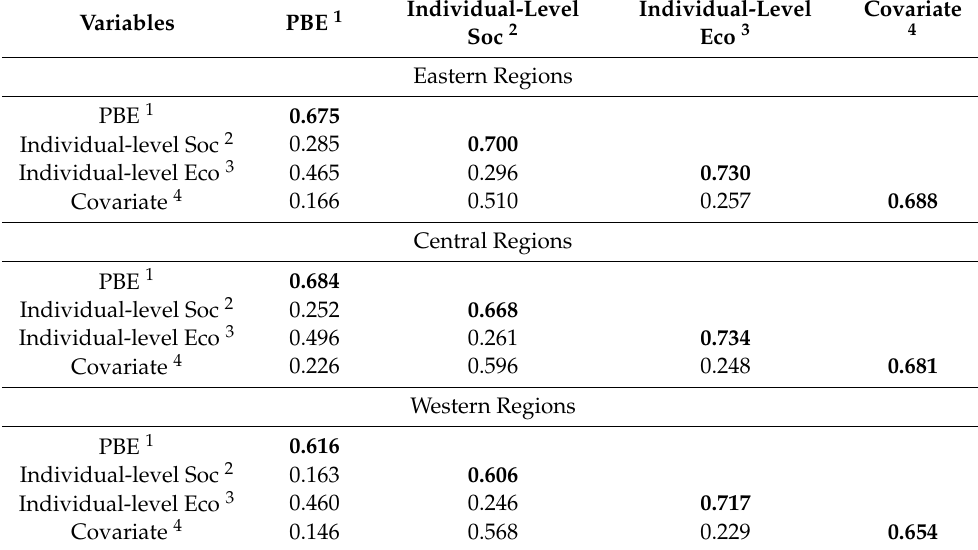
Table A2. Discriminant validity for latent variables with multiple indicators. Variables